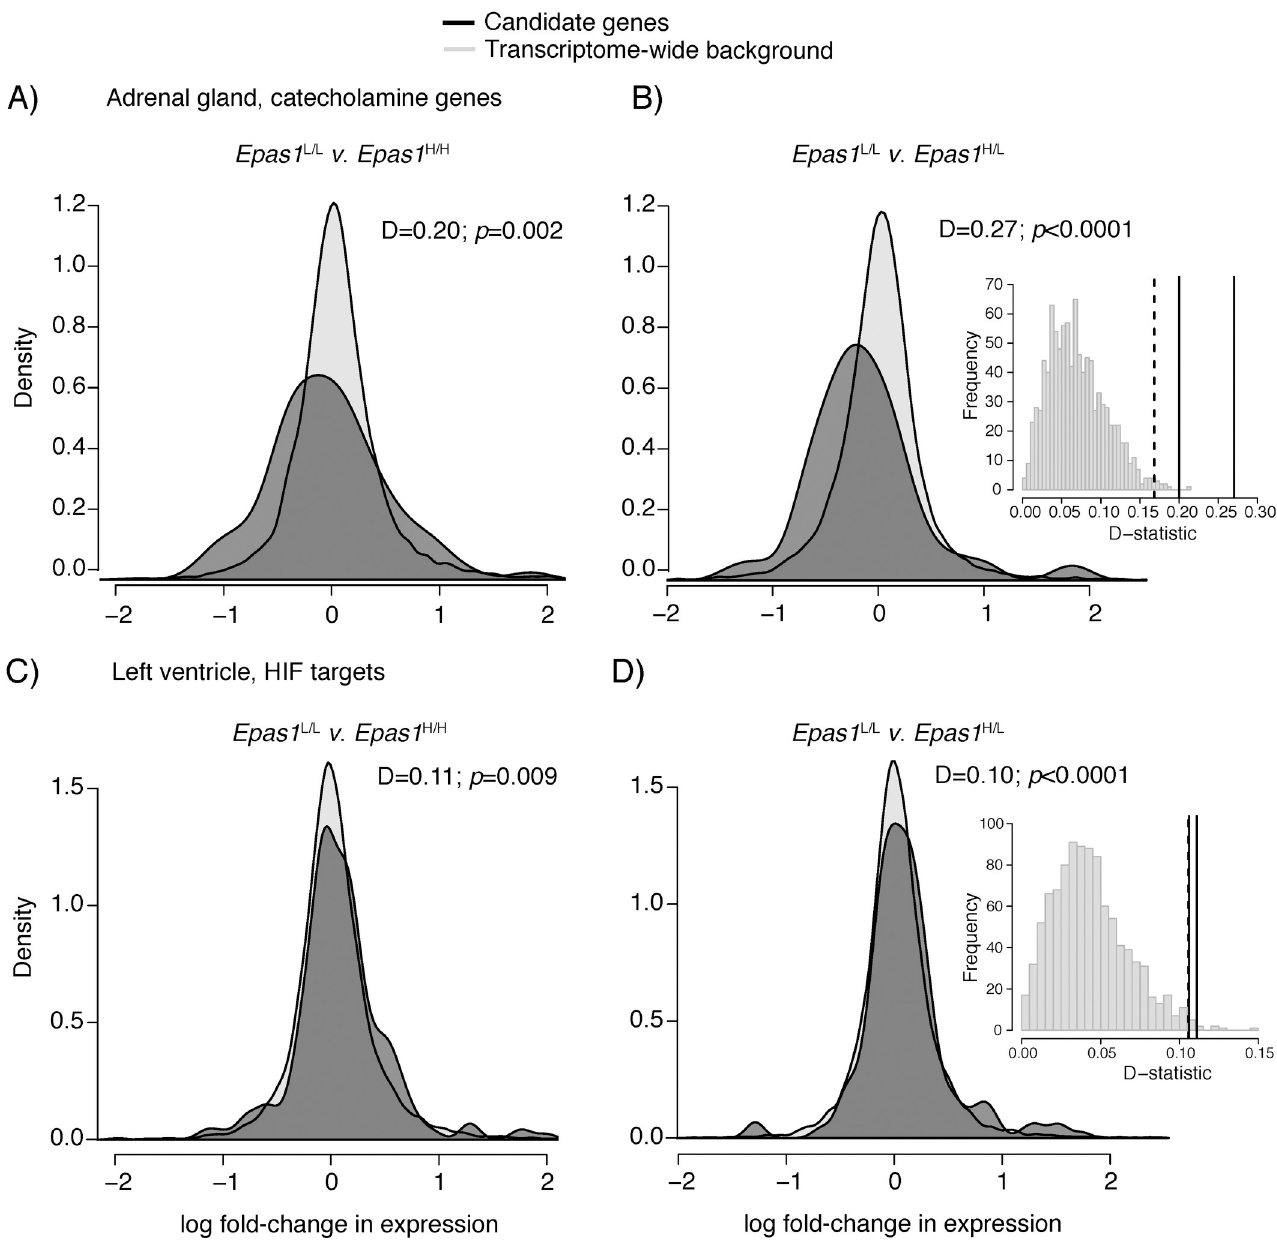
Fig 3. Epas1 genotype affects the regulation of HIF and catecholamine genes. Distribution of log fold-change values between Epas1 L/L v. Epas1 H/H and Epas1 H/L for candidate genes (black) compared the the background transcriptome-wide distribution (grey) for adrenal catecholamine genes (A-B) and left ventricle HIF targets (C-D). Insets show the distribution of K-S test D-statistics for 1,000 randomly permuted datasets tested against the transcriptome-wide background. Dashed indicated the 99% quantile of the null distribution, while solid lines indicate the observed D-statistic for each comparison.